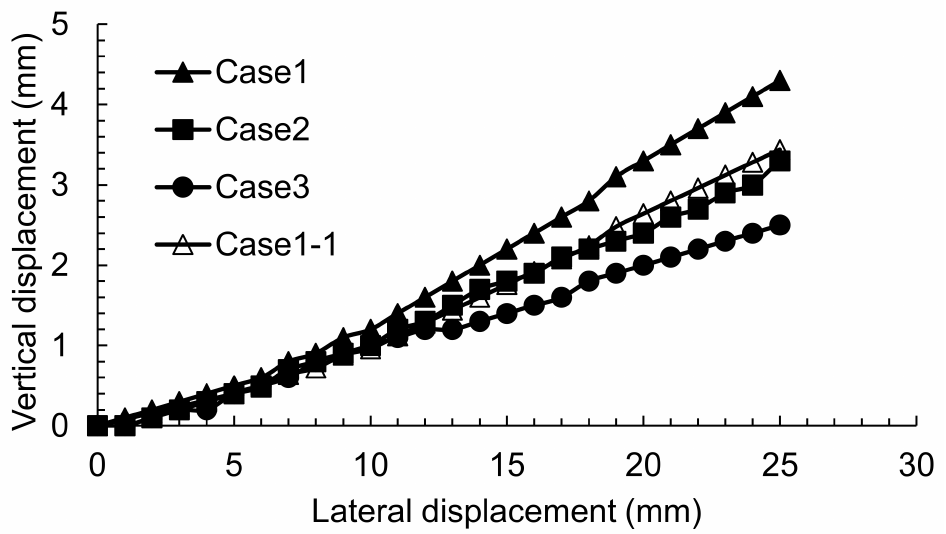
Figure 9. Vertical displacement according to foundation type.